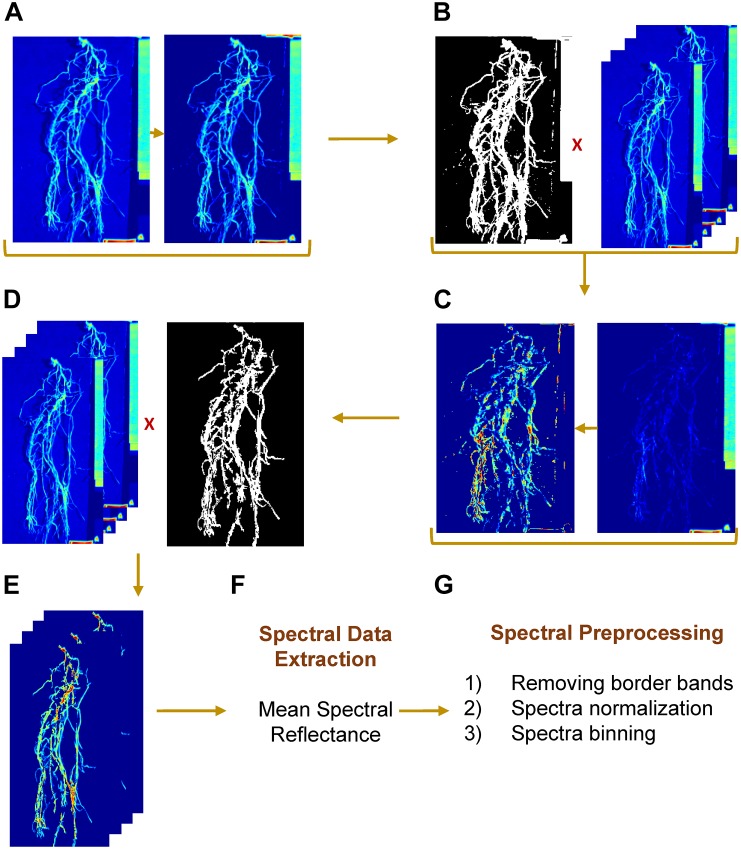
Hyperspectral root image processing and spectral preprocessing steps. (A,B) mask generation, (C,D) label removal, (E) resulting region of interest, (F) spectral data extraction, and (G) spectral preprocessing steps.